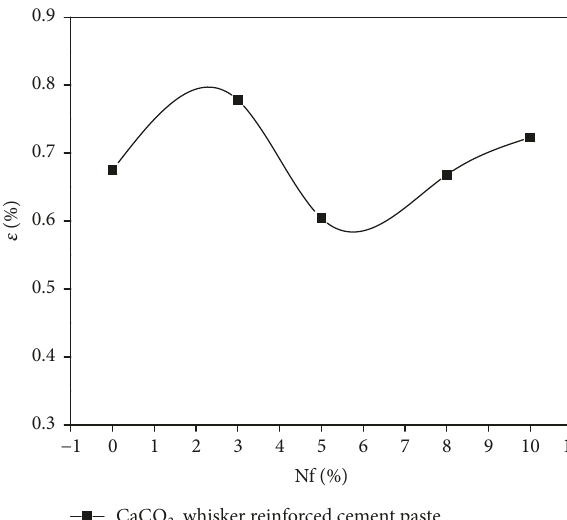
Figure 8: Plot of peak strain against CaCO 3 whisker.